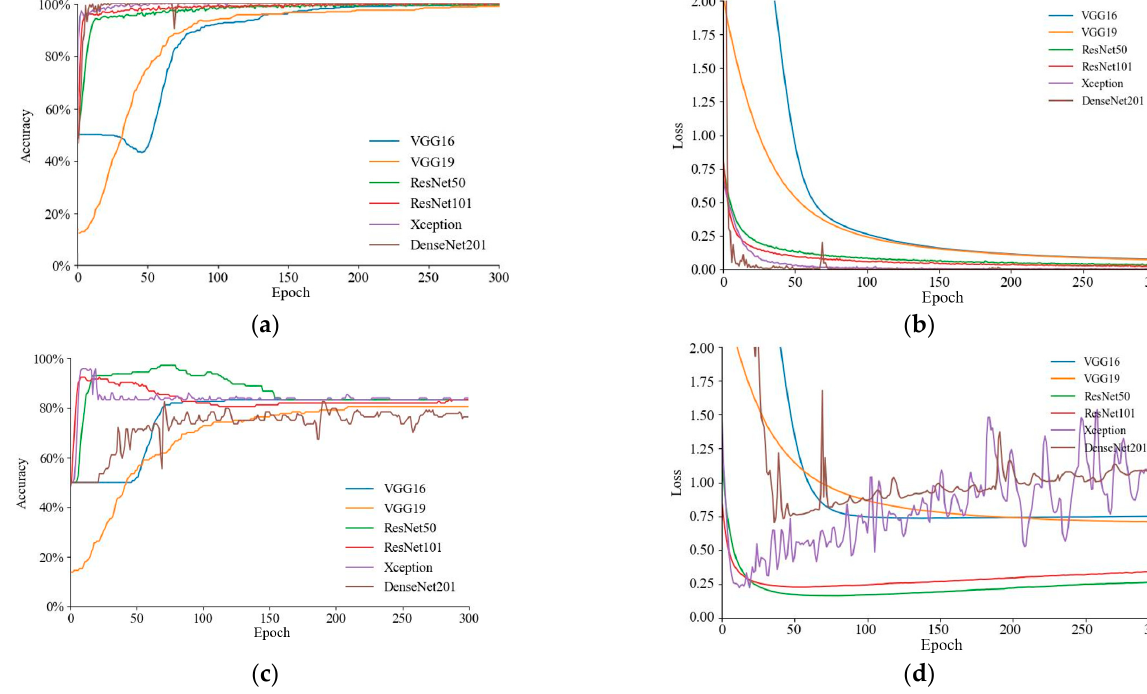
Figure 7. Training curves for six image feature classification models: ( a ) training accuracy curve; ( b ) training loss curve; ( c ) validation accuracy curve; and ( d ) validation loss curve.